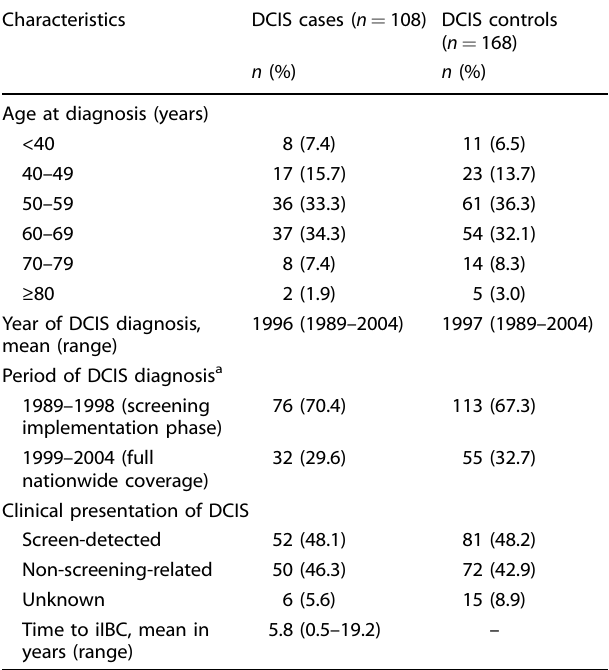
Table 1. Baseline clinical characteristics of women with primary